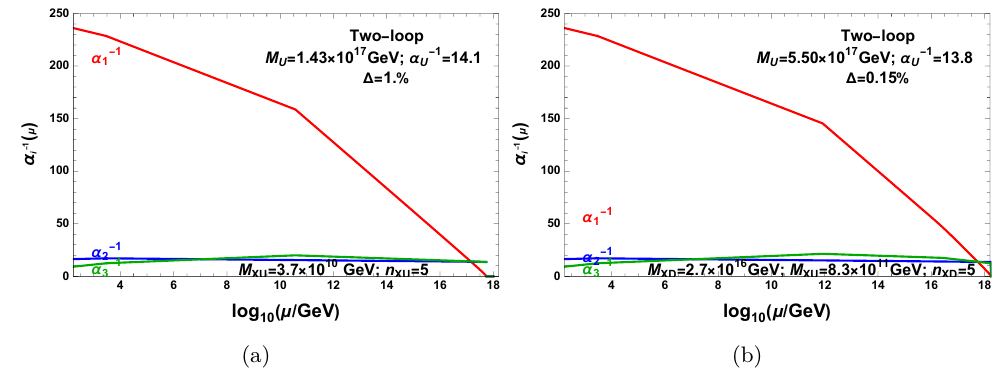
Figure 9 . Two-loop evolution of gauge couplings for the Model 17 with vector-like particles. In the model, k = 1 × 5 and k = 11 . The string-scale gauge coupling relations can be achieved by Y 2 4 3 6 adding 5( XU + XU ) (a) as well as 5( XD + XD ) (b).